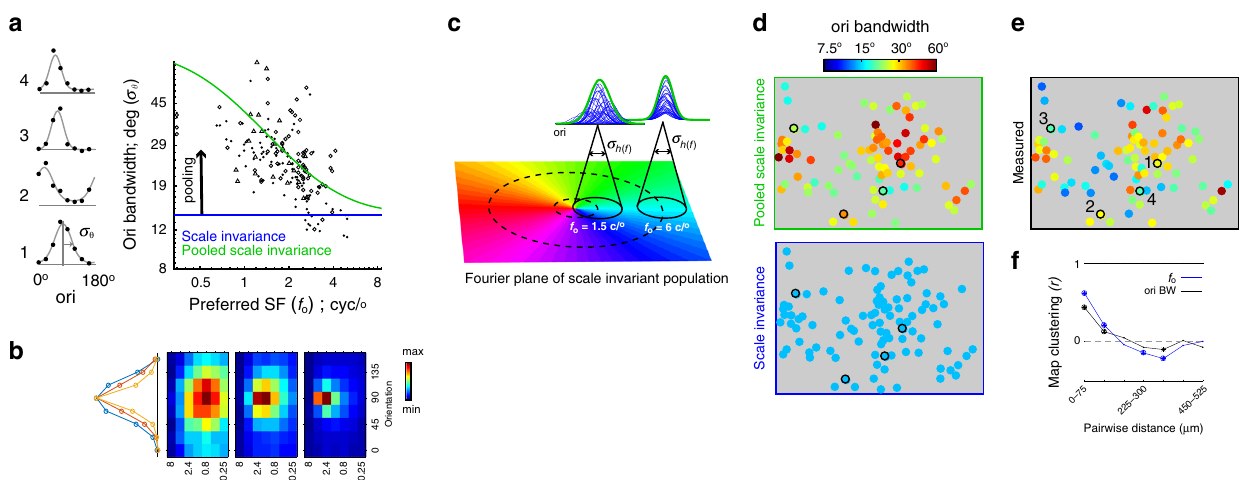
Fig. 6 Orientation (ori) bandwidth as a function of preferred SF ( f o ). a The scatter plot compares f o to ori bandwidth in three ROIs, each indicated by a different symbol. See Table 2 for joint statistics. The fi ve data points at the extreme left of the x -axis were low pass in SF. The blue line is the ori bandwidth based on a scale invariant aspect ratio of 2.0. The green line is the model of pooled scale invariance, which did not require any additional parameters. Rather, it was derived from the fi t to SF bandwidth (Fig. 5a, green). To the left of the y -axis are ori tuning curves (black dots) and Gaussian fi ts (gray) of four example cells in one ROI outlined and enumerated in e . b Each of the three images represents the average response from a different subpopulation, as a function of SF ( x -axis) and ori ( y -axis). Blue-to-red represents normalized response from min-to-max, for each panel. The image on the right is the mean over cells with f o > 2 cyc/°, the middle image is over cells with 1 < f o < 2 cyc/°, and the left image is over f o < 1 cyc/°. Curves on the left are the mean ori tuning curves computed from the three images on the right; they are averaged over the SF dimension. Blue, red, and yellow are for the images from left to right, respectively. c Simulation of the pooling model in the 2D spectral domain, at f o = 1.5 and 6 cyc/°. At bottom is an angled perspective of the 2D Fourier plane, where the color represents orientation and f o increases linearly away from the center. Each location of the 2D Fourier plane corresponds to a different 2D scale invariant Gaussian. Pooling closer to the origin (@ 1.5 cyc/°) yields broader ori tuning than pooling further away from the origin (@6 cyc/°), assuming an invariant pooling function ( σ h ( f ) = 0.85 cyc/°). The simulation on top shows a random sample of weighted and shifted ori tuning curves (blue) from the two indicated pooling locations, along with their superposition (green). d Modeled maps of ori bandwidth. Bottom and top panels are generated by plugging f o into the scale invariance and pooled scale invariance model, respectively. e Measured maps of ori bandwidth. f Pearson correlation coef fi cient between neural pairs, within 75 μ m cortical distance bins, using all three ROIs in the study. The symbol at each distance bin indicates the correlation coef fi cient ’ s signi fi cance: Closed dot is p > 0.01, asterisk is p < 0.01, asterisk and open circle is p <